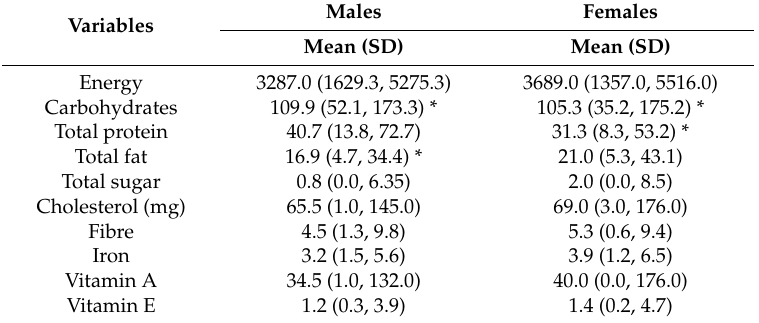
Table 3. Descriptive statistics for 24 h recall dietary intake by gender of Ellisras rural youth aged 18–30 years (n =